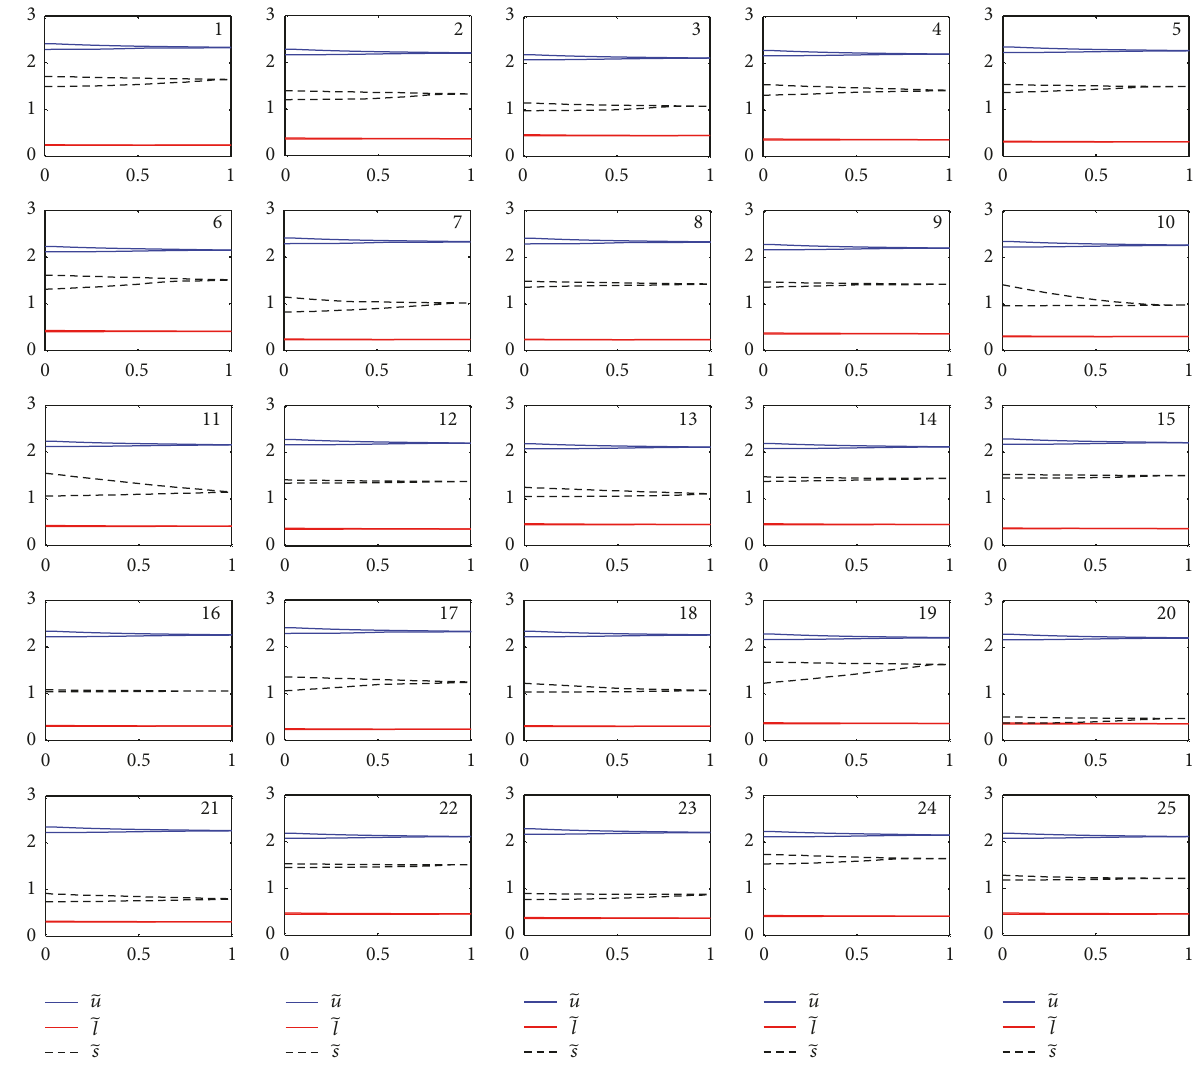
Figure 5: Fuzzy 𝑠 chart for roughness height of optical